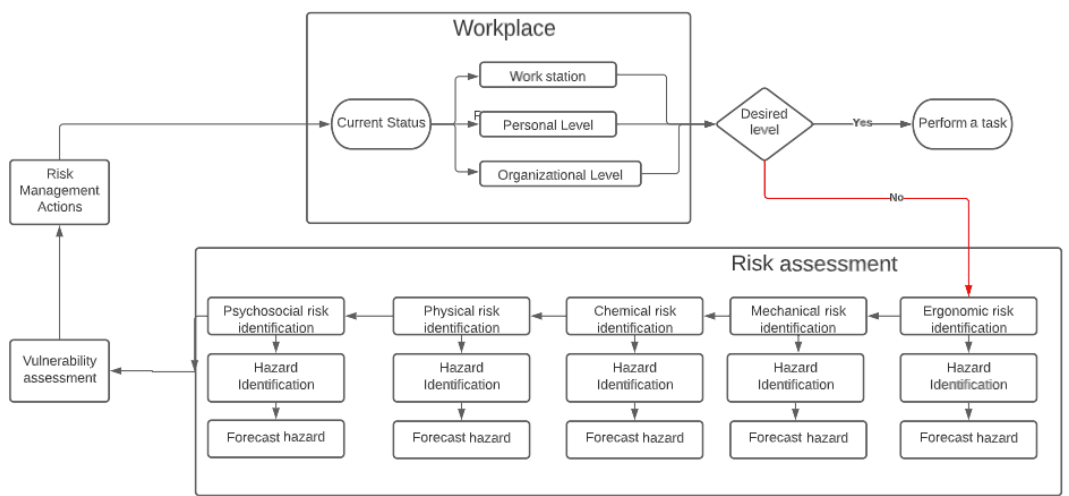
Figure 3. Workplace evaluation method.